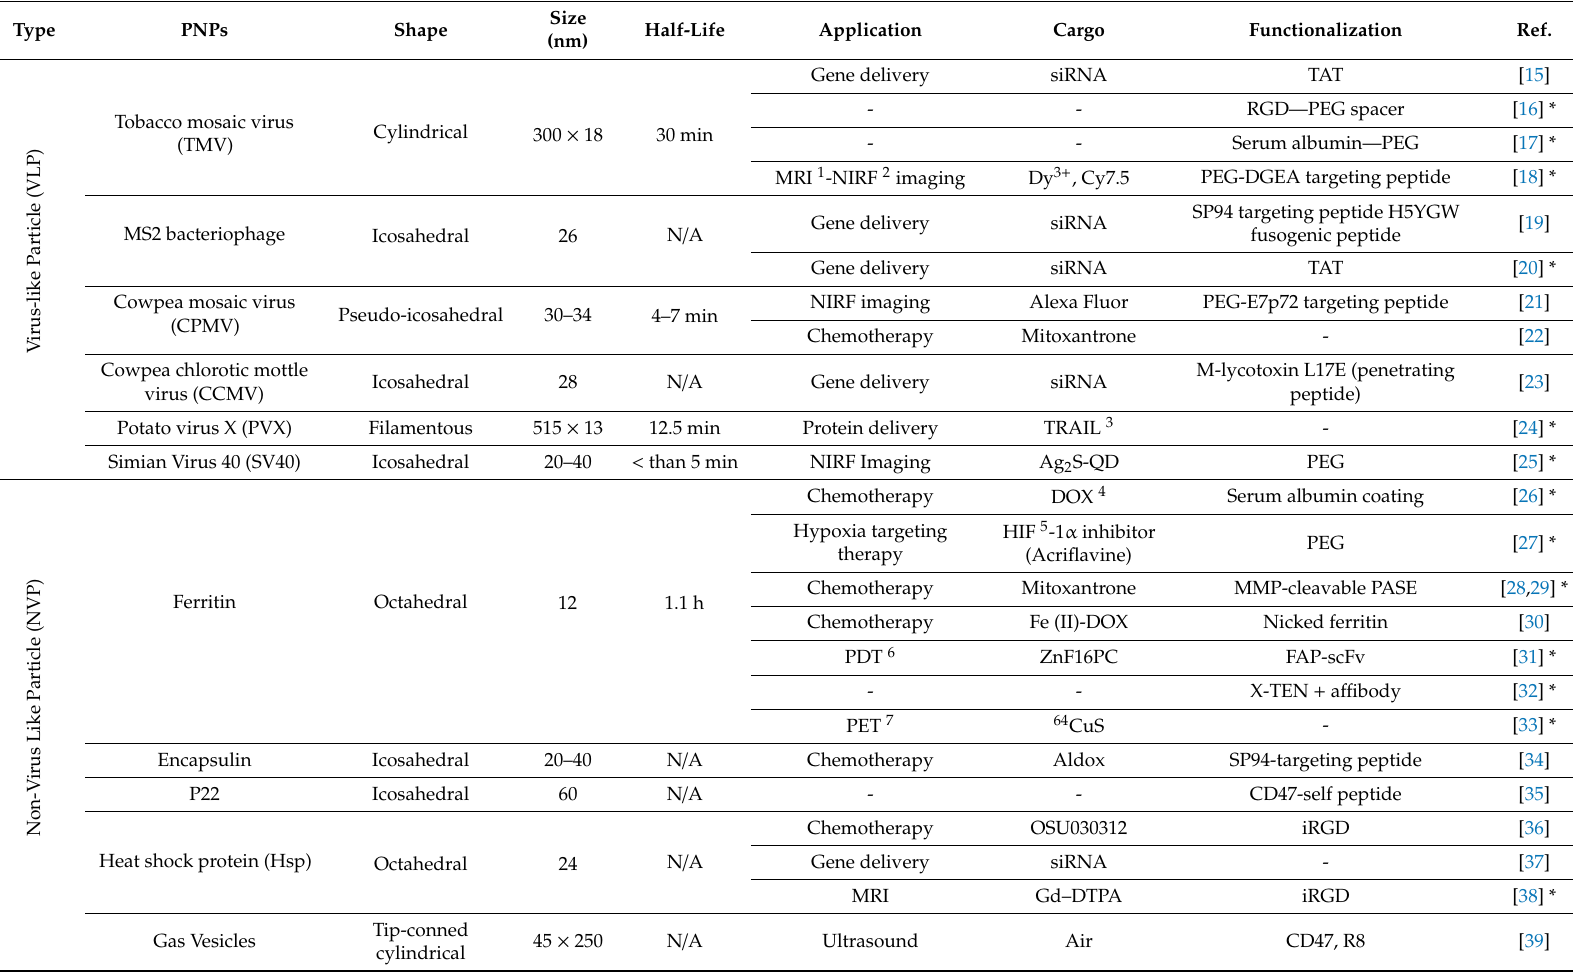
Table 1. Example of protein-based nanoparticles (PNPs) and their application in cancer therapeutics and imaging agent delivery (in this